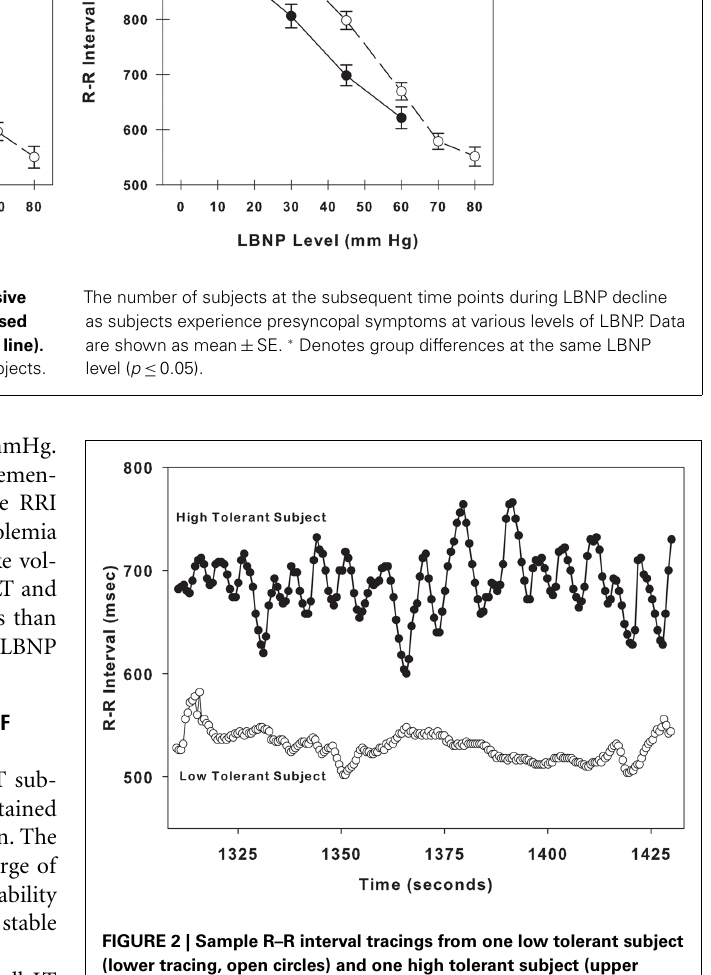
FIGURE 2 | Sample R–R interval tracings from one low tolerant subject (lower tracing, open circles) and one high tolerant subject (upper tracing, closed circles) are shown for a 2-min time span during LBNP level of −